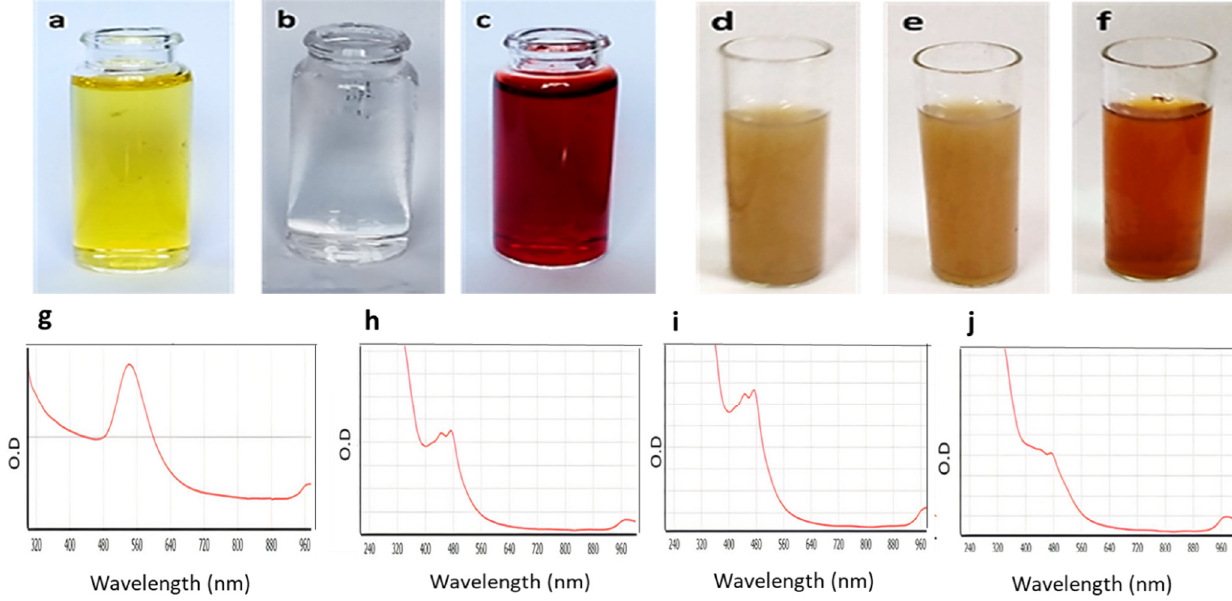
Figure 2. The upper panel shows the gold nanoparticles’ preparation steps: ( a ) HAuCl 4 · 3H 2 O only, ( b ) HAuCl 4 · 3H 2 O + GSH at pH 8, ( c ) formation of gold after the addition of NaBH 4 , and formation of gold nano-conjugates, ( d ) GNP-kaempferol, ( e ) GNP-chrysin, and ( f ) GNP-quercetin. The lower panels show ( g ) the UV-VIS spectra of the GNPs, ( h ) the UV-VIS spectra of GNP-kaempferol, ( i ) the UV-VIS spectra of GNP-chrysin, and ( j ) the UV-VIS spectra of GNP-quercetin.